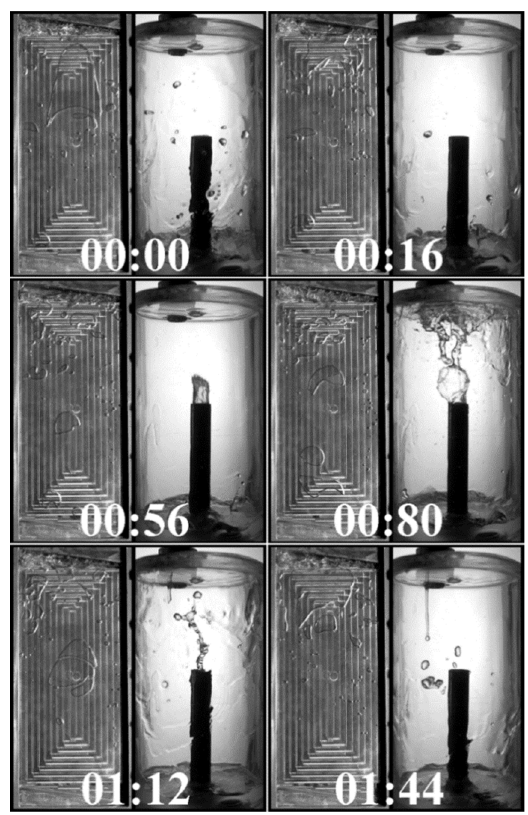
Figure 3. Visualization of the vapor lifting of liquid (one working cycle of the evaporator–separator system); the vapor bubble enters the outlet manifold and pushes out the column of boiling liquid after 0.56 seconds.